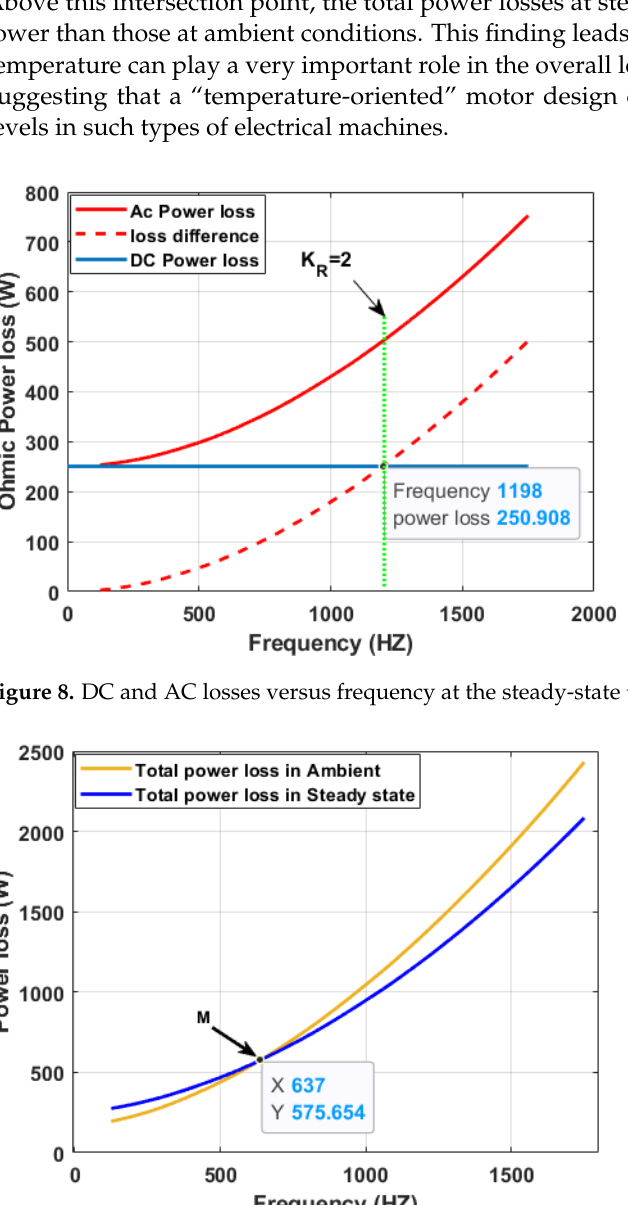
Figure 9. Comparison in terms of total losses versus frequency between ambient and steady-state temperature operation.